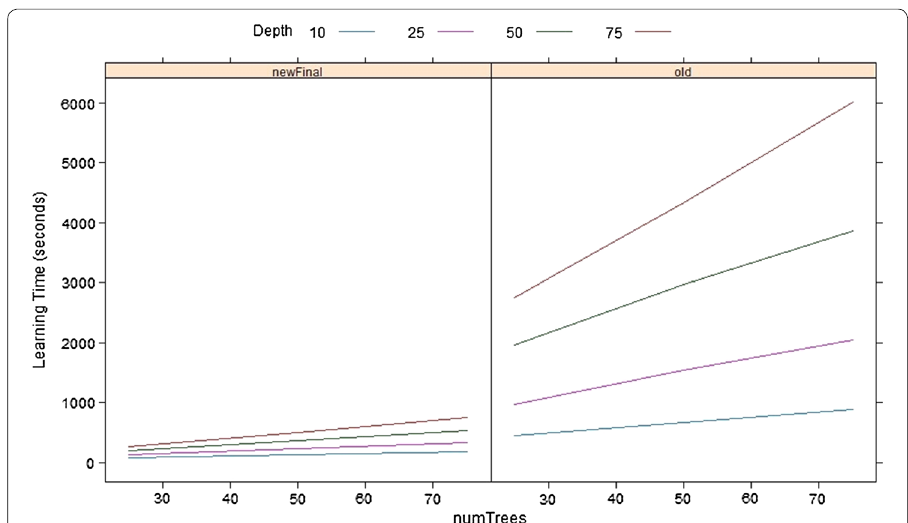
Fig. 12 Final Learning runtime comparison increasing Number of trees (numTrees)